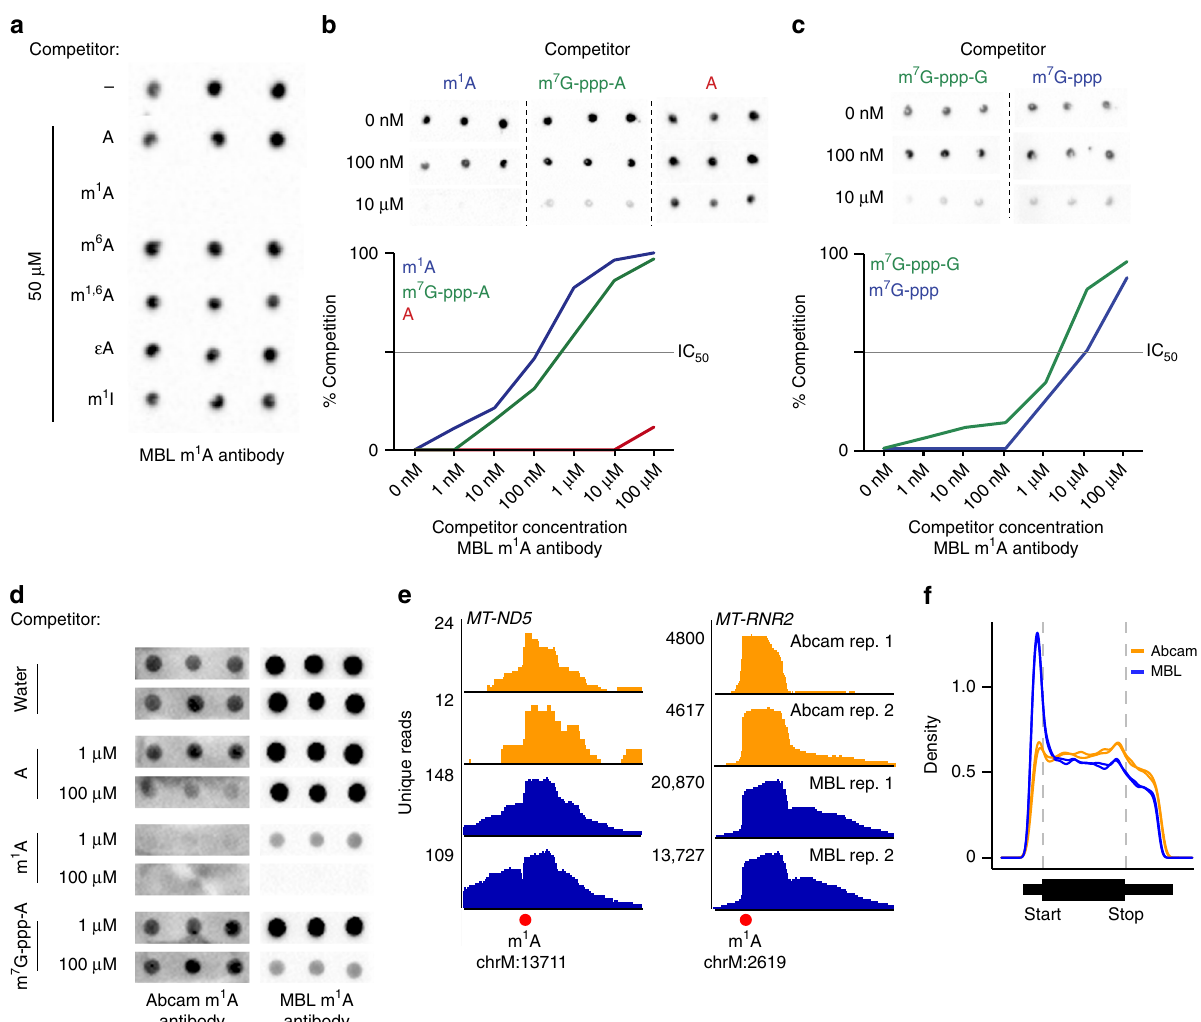
Fig. 4 The AMA-2 m 1 A antibody binds to mRNA caps resulting in 5 ′ UTR read enrichment. a Shown is a dot blot analysis of the AMA-2 m 1 A antibody ’ s speci fi city. An m 1 A-containing oligonucleotide was spotted on a nylon membrane in triplicate and the antibody was incubated with the membrane along with m 1 A-like nucleosides. Only m 1 A prevents antibody binding to the spotted oligonucleotide. m 1,6 A N 1,6-methyladenosine, ε A ethenoadenosine, m 1 I 1- methylinosine. b Top, images of dot blot competition assays 1 where binding of the AMA-2 m 1 A antibody to an m 1 A-containing oligonucleotide was competed with m 1 A (m 1 ATP), m 7 G-ppp-A, or A (ATP) in triplicate. Bottom, quanti fi cation of dot blot competition experiments. m 7 G-ppp-A binds (IC 50 < 1 μ M) to the antibody, although the binding is ~10-fold weaker than m 1 A (IC 50 = ~100 nM). Source data are provided as a Source Data fi le. c The AMA-2 m 1 A antibody recognizes the m 7 G-ppp portion of the cap structure. The membrane was probed with the antibody along with m 7 G-ppp or m 7 G-ppp-G. Both m 7 G-ppp and m 7 G-ppp-G competed with the m 1 A oligonucleotide for binding to the antibody (IC 50 = ~4 μ M for m 7 G-ppp-G, 10 μ M for m 7 G-ppp). Source data are provided as a Source Data fi le. d The Abcam m 1 A antibody (ab208196) does not bind the mRNA cap. Dot blots were performed with either of the two m 1 A antibodies (AMA-2 or Ab208196) in the presence of A, m 1 A, or m 7 G-ppp-A (A and m 1 A were either tri- or mono-phosphorylated). While both antibodies bind m 1 A, only the AMA-2 antibody binds m 7 G-ppp-A. e The m 1 A antibodies from Abcam (ab208196) and MBL (AMA-2) both detect established m 1 A sites. m 1 A-miCLIP unique reads from two independent antibodies (in replicate) were aligned to the genome, and peaks at known m 1 A sites (red circle) in MT-ND5 and the mitochondrial 16S rRNA ( MT-RNR2 ) exhibited a characteristic truncation at the m 1 A site. f The m 1 A antibody